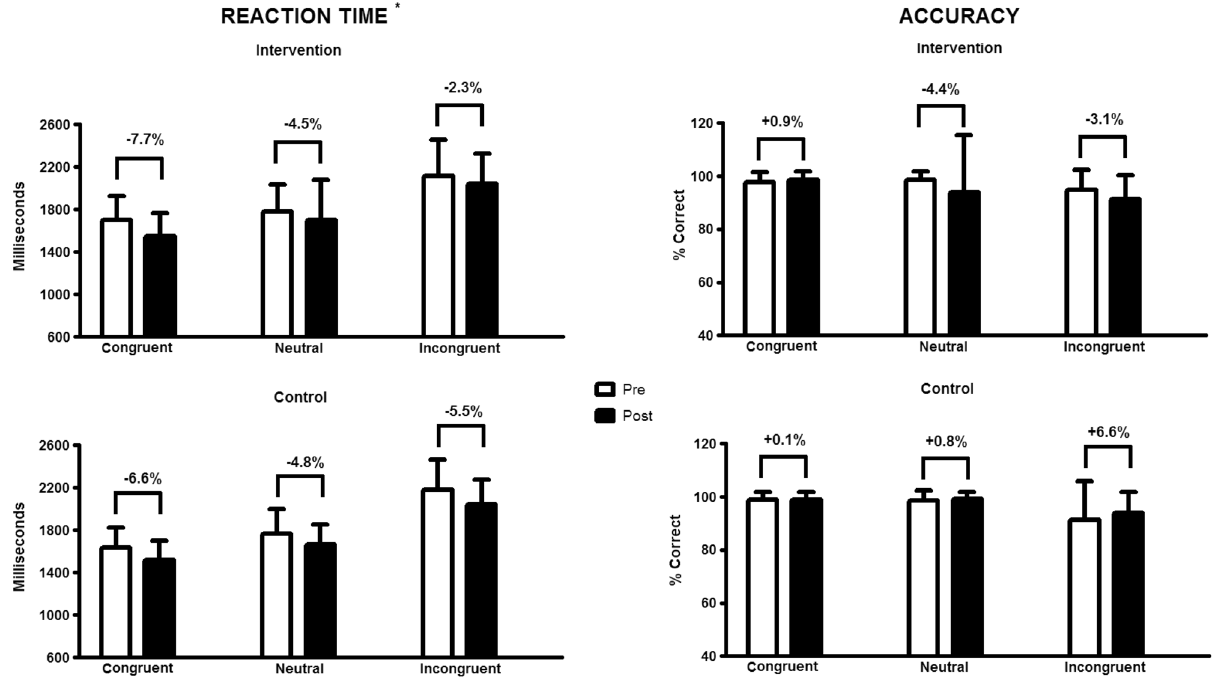
Figure 2. Stroop Color test results (reaction time and accuracy) pre and post 16 weeks. Data are expressed by the mean and standard deviation. Note : * p < 0.05 for time in all the phases (congruent: p < 0.001; neutral: p = 0.011; incongruent: p =